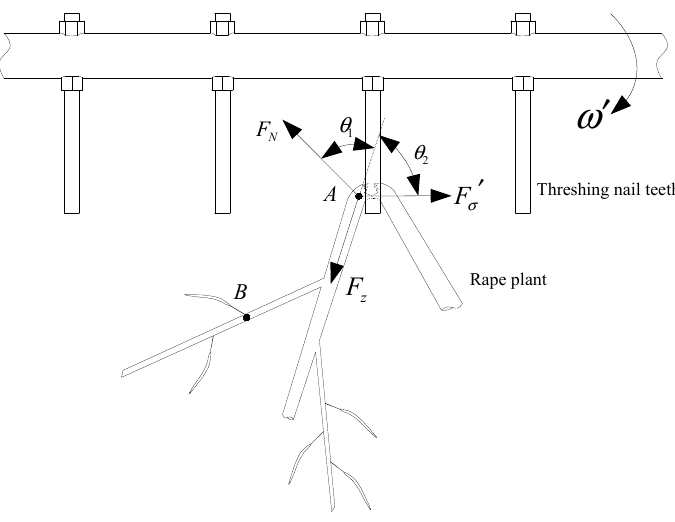
Figure 1. Analysis of shifting force on rape plant by reel finger.